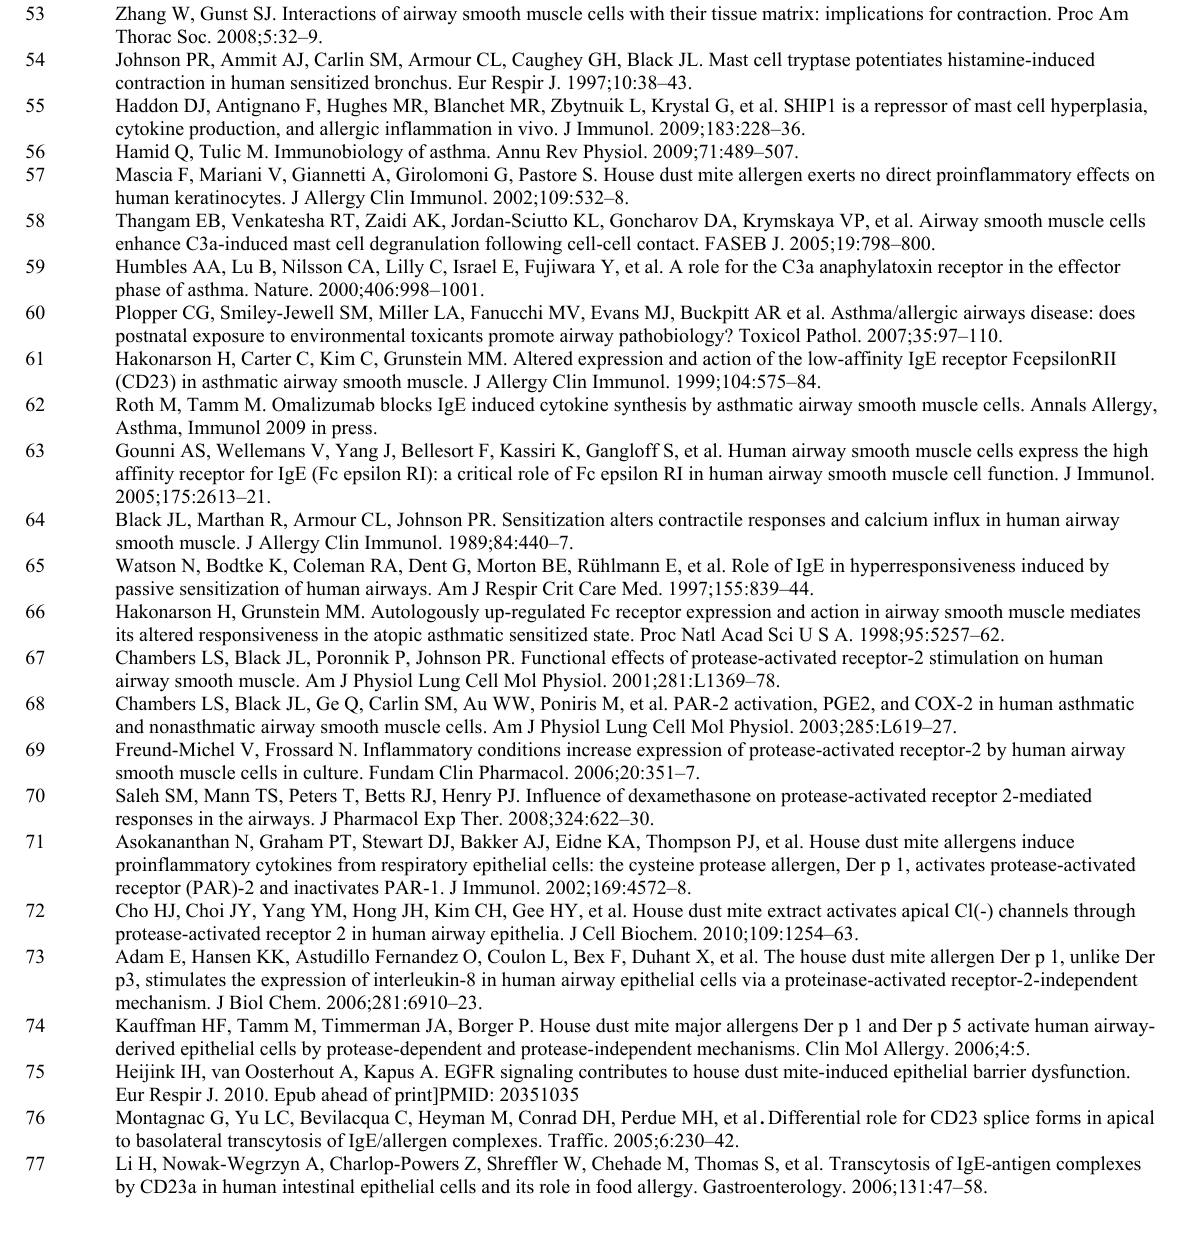
Summary of cell type specific pathologies of isolated human airway smooth muscle cells obtained from patients with asthma when compared to cells isolated from either healthy controls or patients with chronic obstructive pulmonary disease. ECM: extracellular matrix,